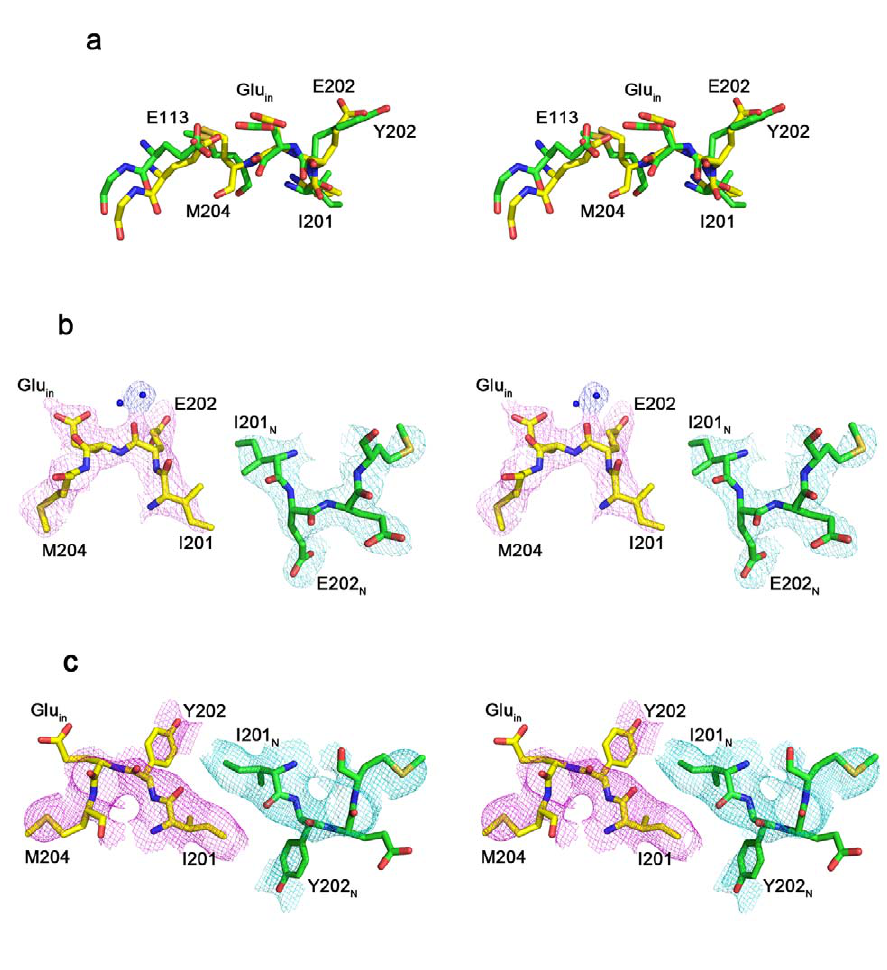
Figure 4. Structural changes in E202Y. The mutant backbone is basically unaltered from wild type (C a rmsd 0.9 A˚). (a) Structural comparison between wild-type ( D NC) and E202Y mutant near the E202 residue. Residues are colored in yellow (for wild type) or green (for E202Y), red (oxygen), and blue (nitrogen). Cytoplasmic side view into the apex region of the interfacial pathway for wild type (b) and E202Y (c). E202 N and I201 N indicate residues coming from the neighboring subunit of the homodimer. Crystallographic water molecules are shown in blue dots. 2F o -F c maps are contoured at 1.0 s .